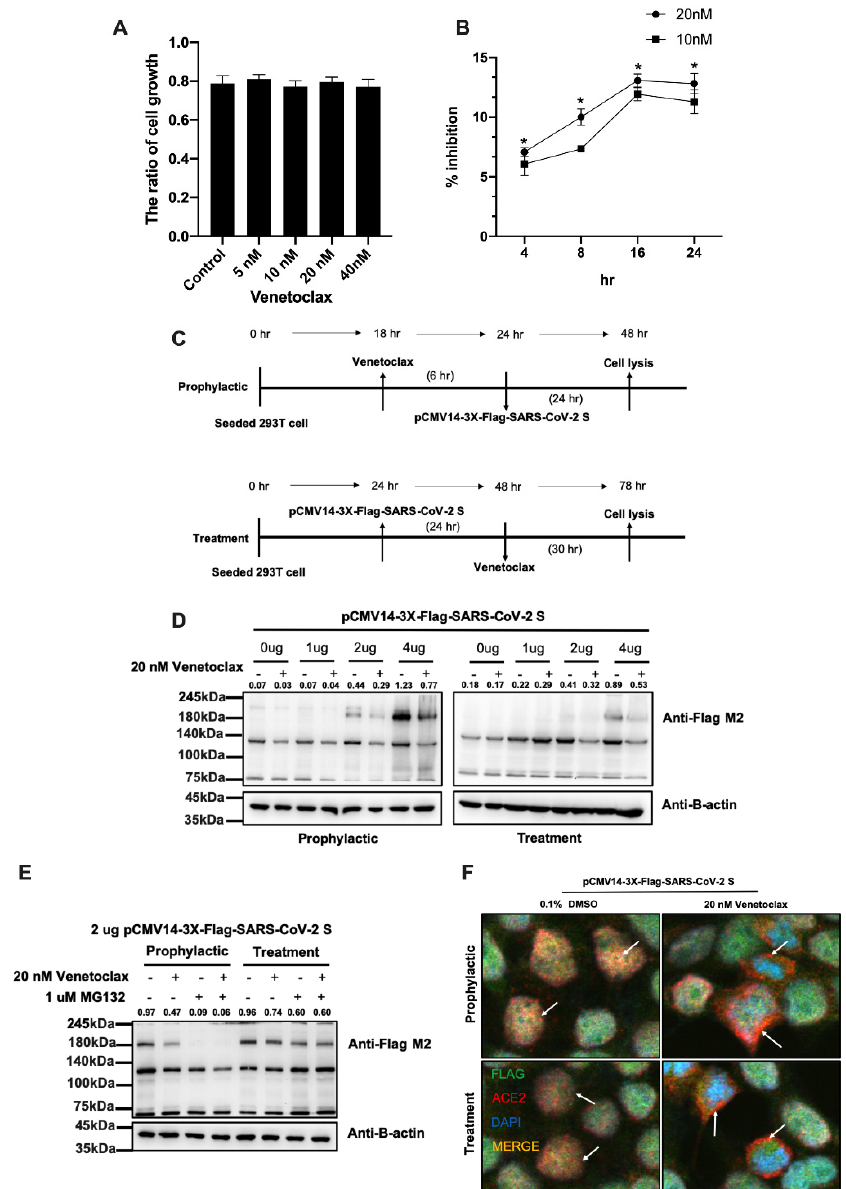
Figure 5. Venetoclax blocked the interaction between the SARS-CoV-2 spike protein and ACE2. ( A ) The cell was treated with 5, 10, 20, and 40 nM Venetoclax, and cell growth was analyzed by a CCK-8 assay at 24 h in HEK293T. ( B ) The inhibitor screening assay of Venetoclax (20 and 40 nM) was analyzed by the SARS-CoV-2 Neutralization Antibody ELISA Kit at 4, 8, 16, and 24 h. ( C ) In the prophylactic group, HEK293T cells were exposed to 20 nM Venetoclax for 6 h and transfected with the SARS-CoV-2 spike protein. After 24 h, cells were collected using a RIPA buffer, and the lysates were stored at − 20 ◦ C. In the treatment group, HEK293T cells were transfected with the SARS-CoV-2 spike protein for 24 h and exposed to 20 nM Venetoclax. After 30 h, cells were collected using a RIPA buffer, and the lysates were stored at − 20 ◦ C. ( D ) Detection of the flag (180 kDa) by immunoblotting in cells overexpressed with 0. 1, 2, and 4 ug of pcMV14-3X-Flag-SARS-CoV-2 S plasmid. The total level of the flag of the spike protein was detected by immunoblotting. B-Actin was used as a loading control. ( E ) Prophylactic and treatment experiments were performed after adding the proteasome inhibitor MG132 to cells for 1 h. ( F ) The distribution of the flag (Alexa Fluor-488) and ACE2 (Alexa Fluor-555) was determined by immunofluorescence microscopy. Data are the mean values ± SD of three experiments. * p < 0.05 vs. untreated control; two-tailed Student’s t